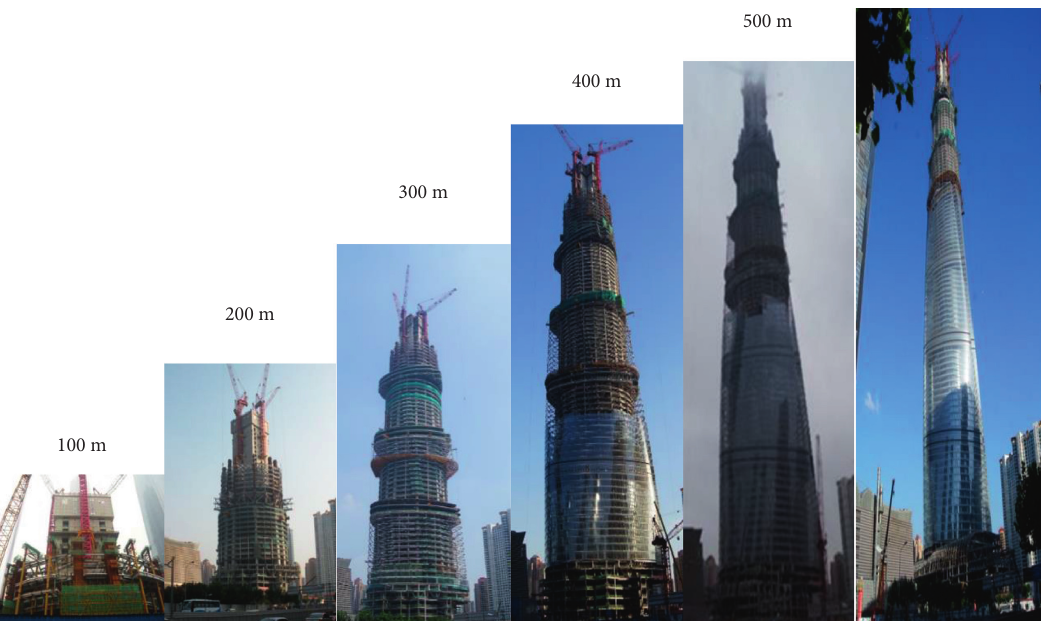
Figure 8: The different concrete pumping heights for the Shanghai Tower.